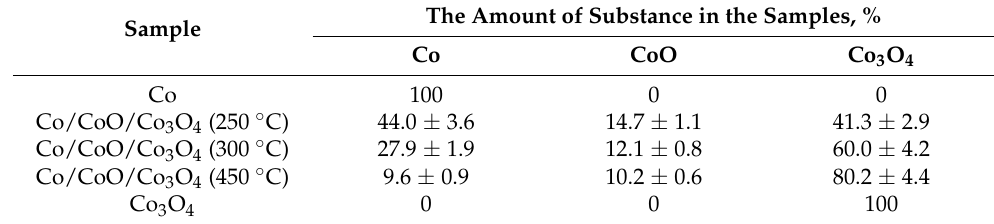
The morphology of Co particles undergoes significant changes after heating to 250 ◦ C